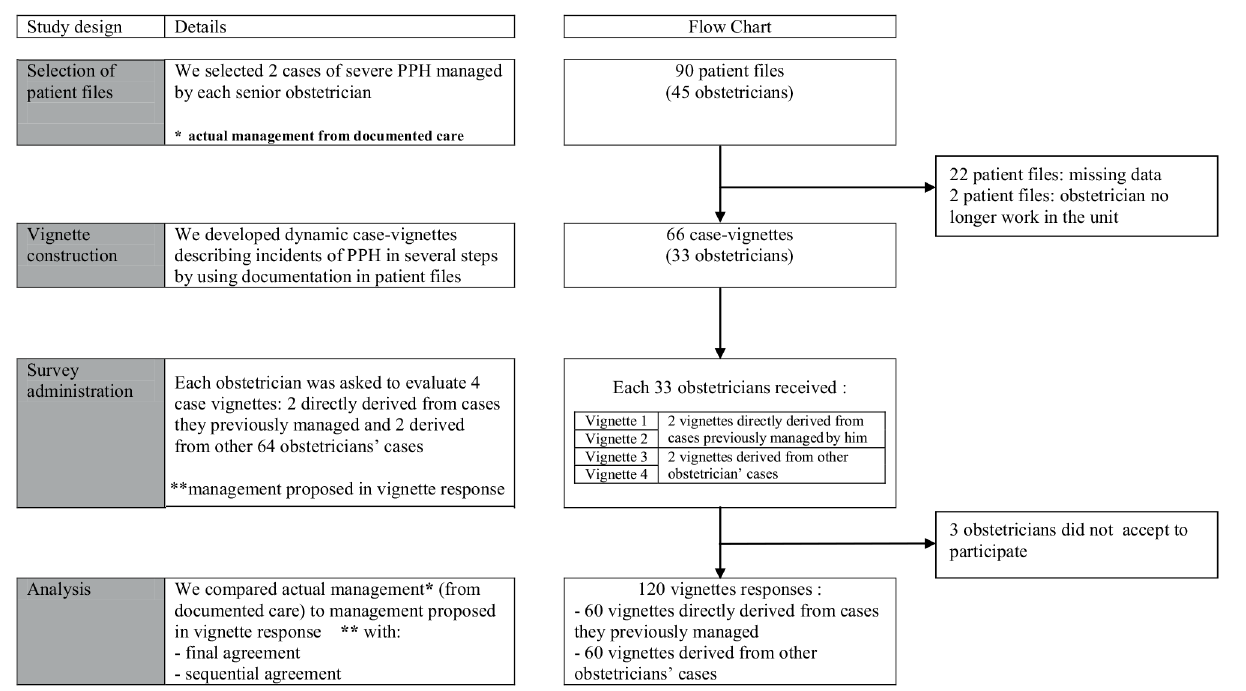
Fig 5. Study design. This figure describes study design and flow chart of the